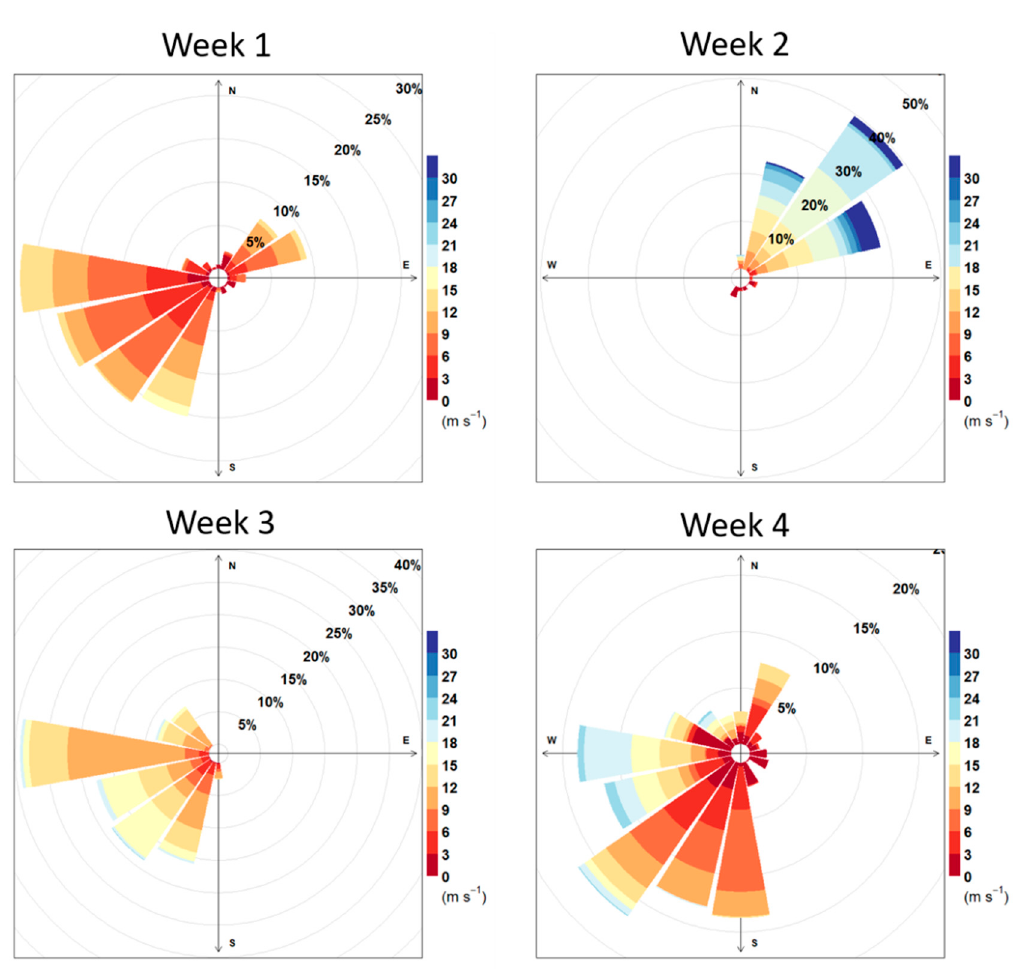
Figure 4. Wind roses for the four sampling sessions. Data is collected from 318 m above sea level; as such, wind speeds are generally higher than at ground level.